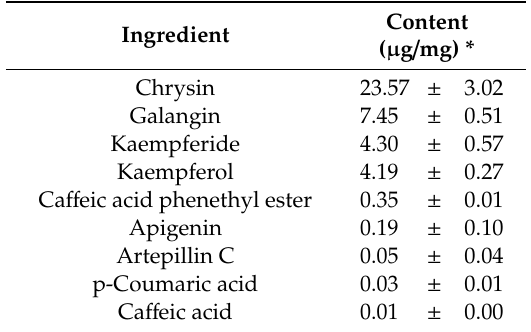
Table 5. Major ingredients and their respective contents in PPL extract.